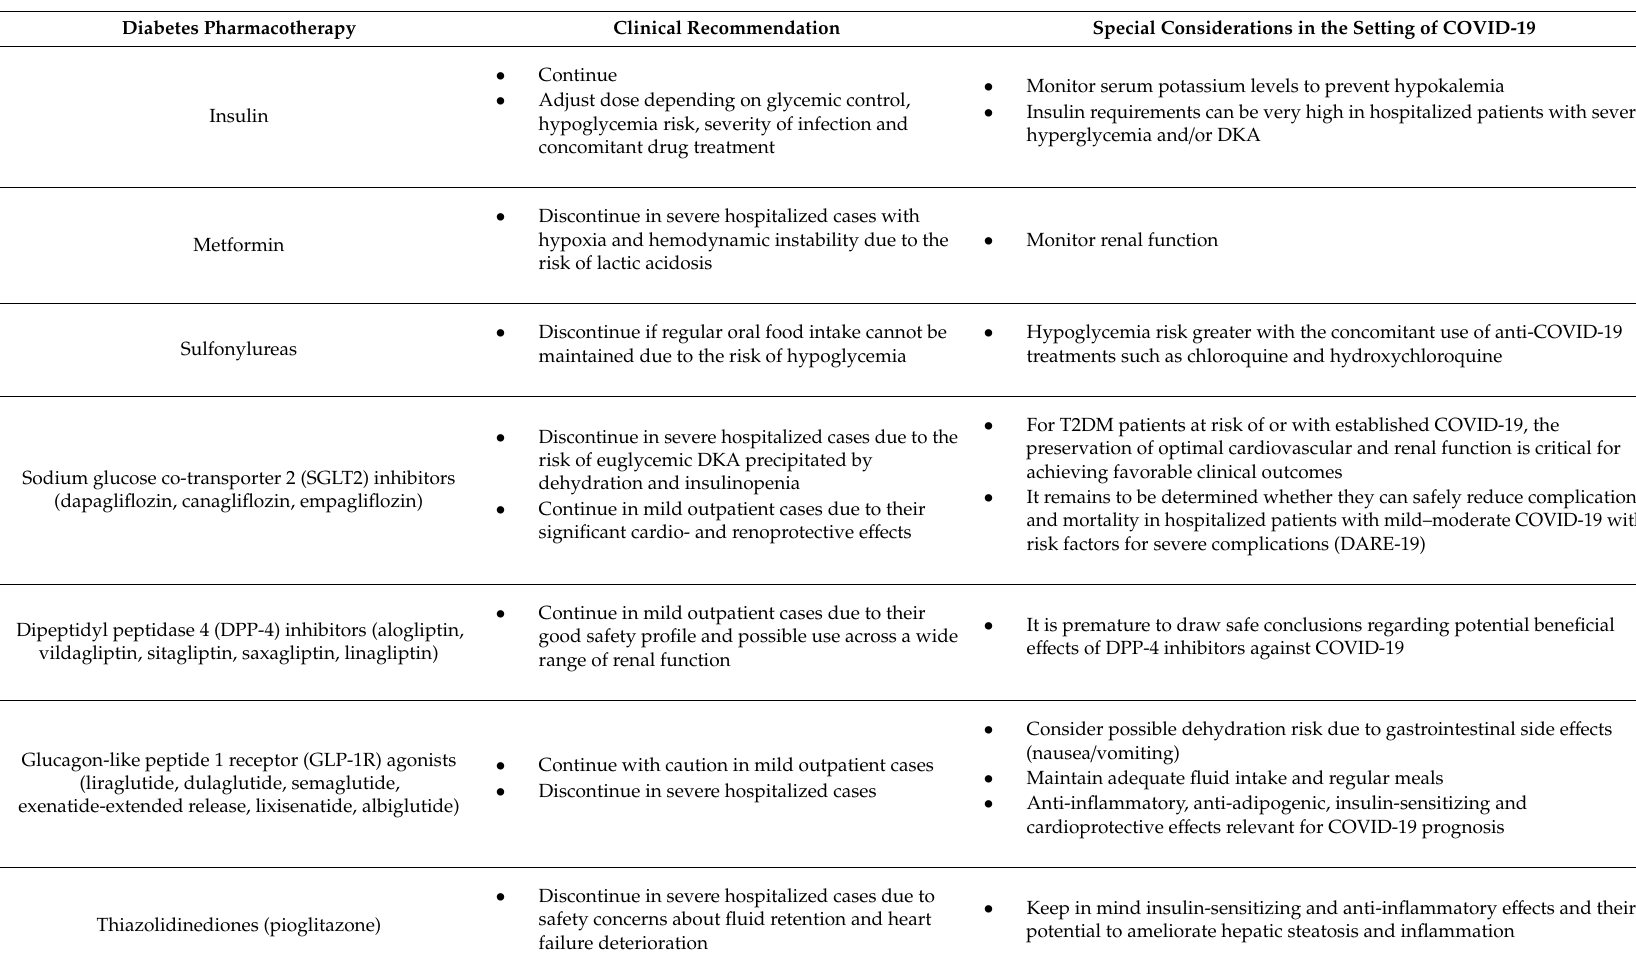
Table 1. Clinical recommendations, special considerations and concerns for the use of specific antidiabetic drug categories in patients with T2DM and